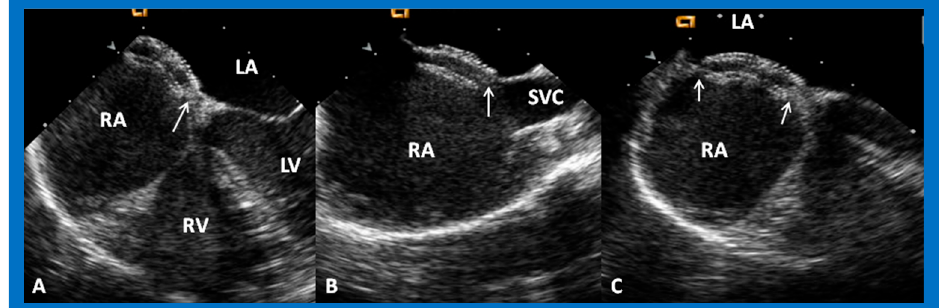
Figure 29. Transesophageal echocardiographic images after the deployment of an Amplatzer Septal Occluder to close an atrial defect, illustrating the location of both the left atrial (LA) and right atrial (RA) discs in four-chamber ( A ), bi-caval ( B ) and long-axis ( C ) projections. It is important to ensure that the septal rims of the atrial defect (thin arrows) are sandwiched in-between the LA and RA discs. LV, left ventricle; RV, right ventricle; SVC, superior vena cava. Replicated from Reference [7].